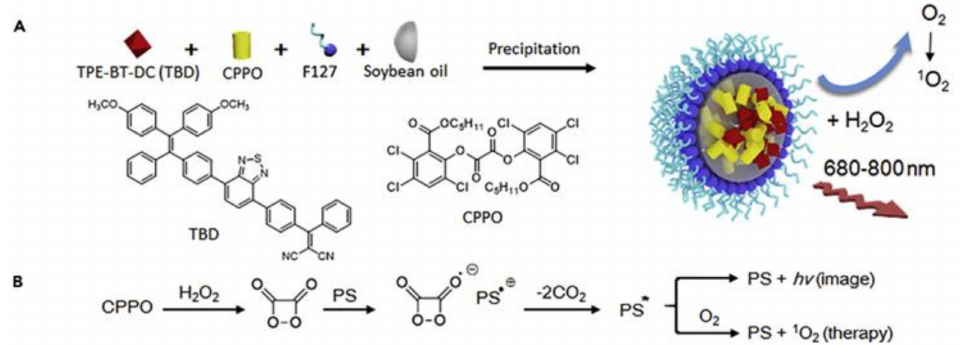
Figure 9. The preparation of chemiluminescence nanoparticles ( A ) Chemiluminescence nanoparticle preparation ( B ) principle for chemiluminescence and 1 O 2 generation [57] Reprinted with